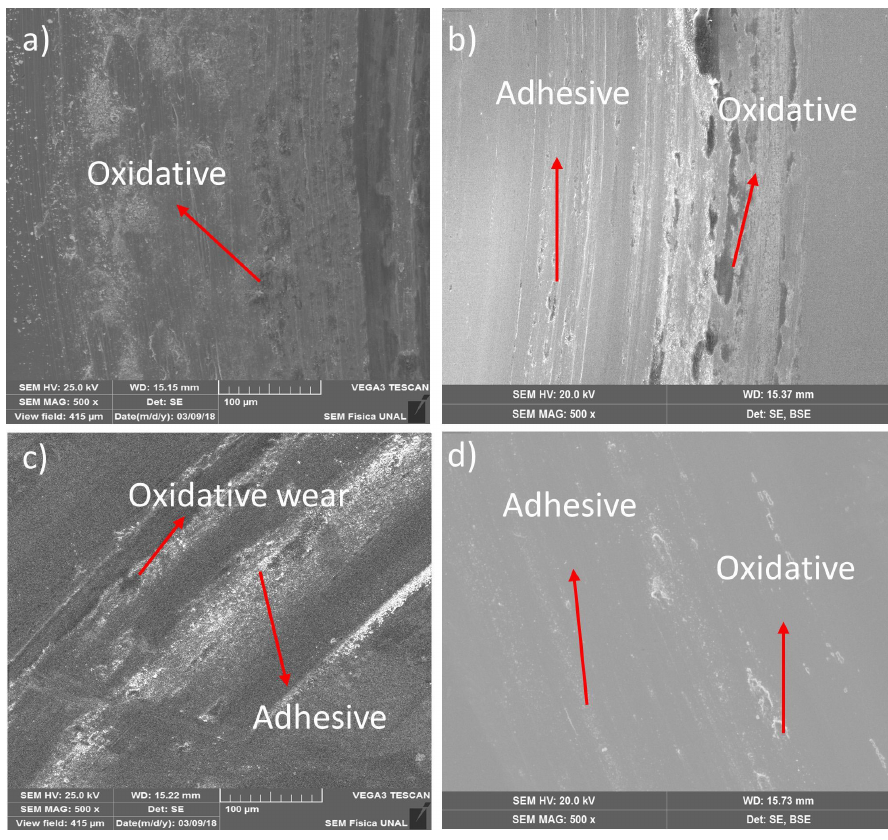
Figure 9. SEM images of coating wear track. a) Substrate, b) M0, c) M3 and